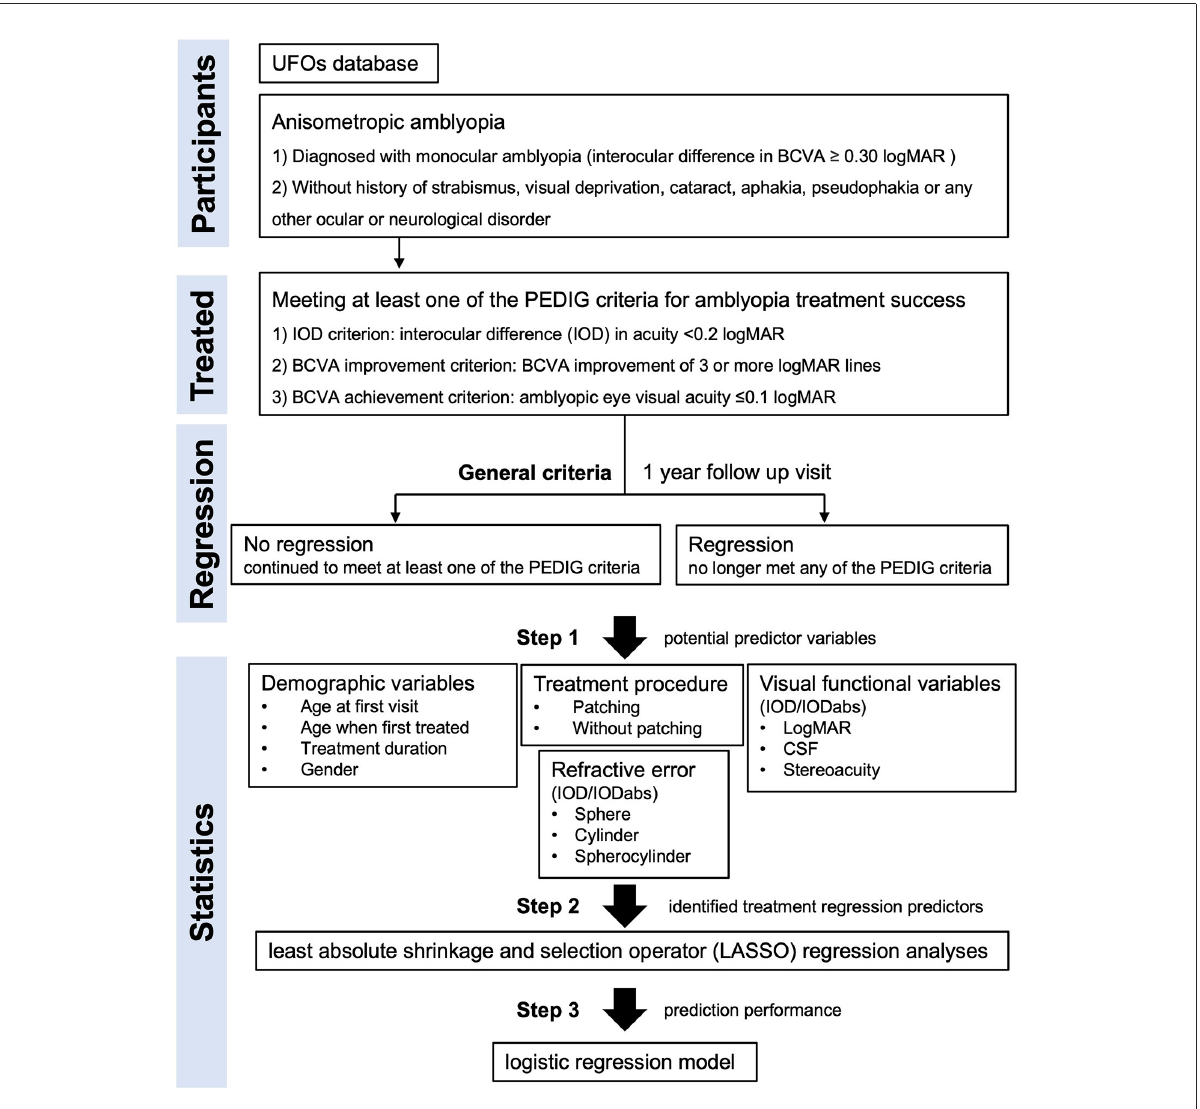
FIGURE1 Flowchart depicting the statistical analysis